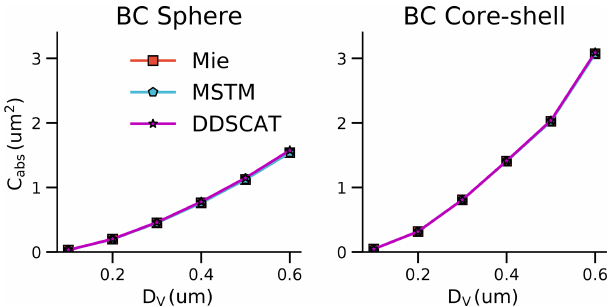
Figure 2. The absorption cross sections of spherical BC calculated using the Mie theory, MSTM, and DDA. For the BC core sphere, the ratio of the shell radius to the core radius was assumed to be 1.5.